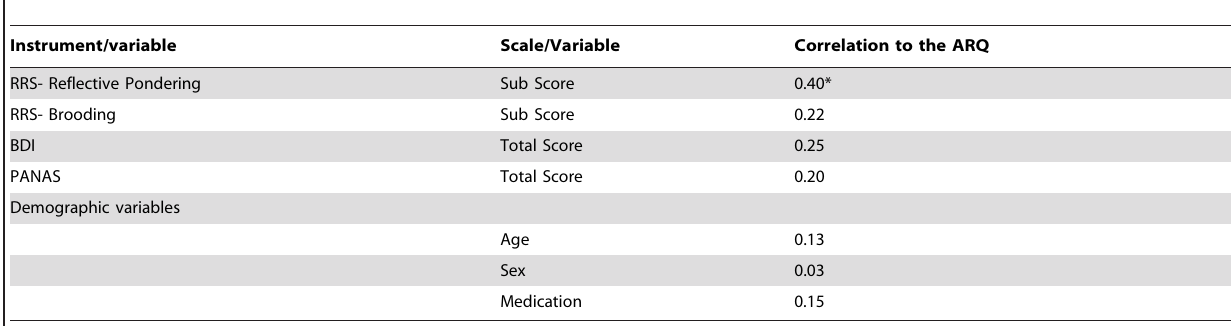
Table 1. Traditional psychometric methods: convergent and discriminant construct validity and group differences validity.